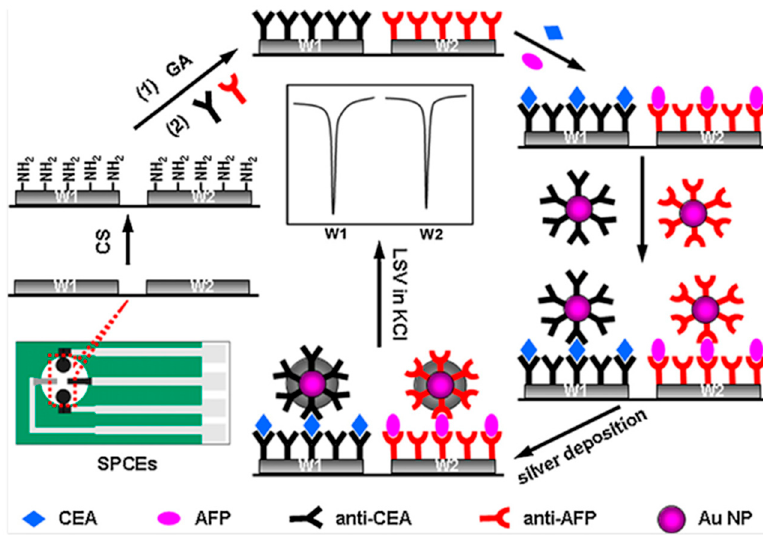
Figure 2. Scheme of the preparation and functioning of a multiplexed immunosensor for the determination of CEA and AFP involving stripping voltammetry of Ag catalytically deposited by gold nanolabels. Reprinted from Ref. [21] with permission.